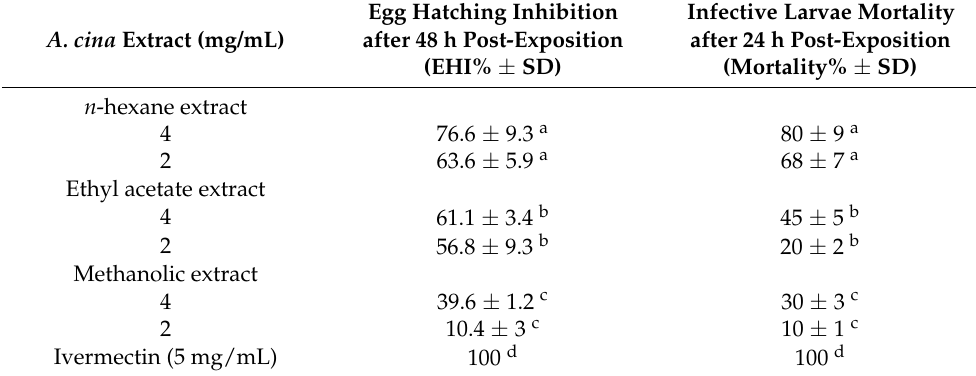
Table 1. In-vitro lethal activity of n -hexane, ethyl acetate and methanol extract of A. cina against H. contortus infective larvae and eggs after 24 h and 48 h, respectively. Egg Hatching Inhibition after 48 h Post-Exposition